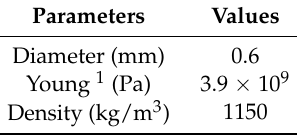
Table 2. Cable parameters.